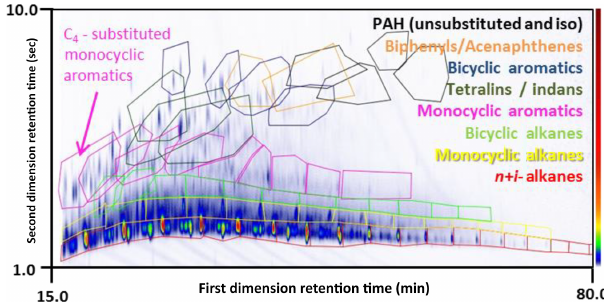
Figure 1. A contour plot (chromatogram with 70eV ionization mass spectrometry) of diesel fuel separation. Peak height (intensity) increases with the warmth (blue to red) of the colour scale. Each re- gion fenced by a coloured polygon marks out the two-dimensional chromatogram space in which isomers of a particular compound type are found with a particular carbon number (e.g. C 4 –substituted monocyclic